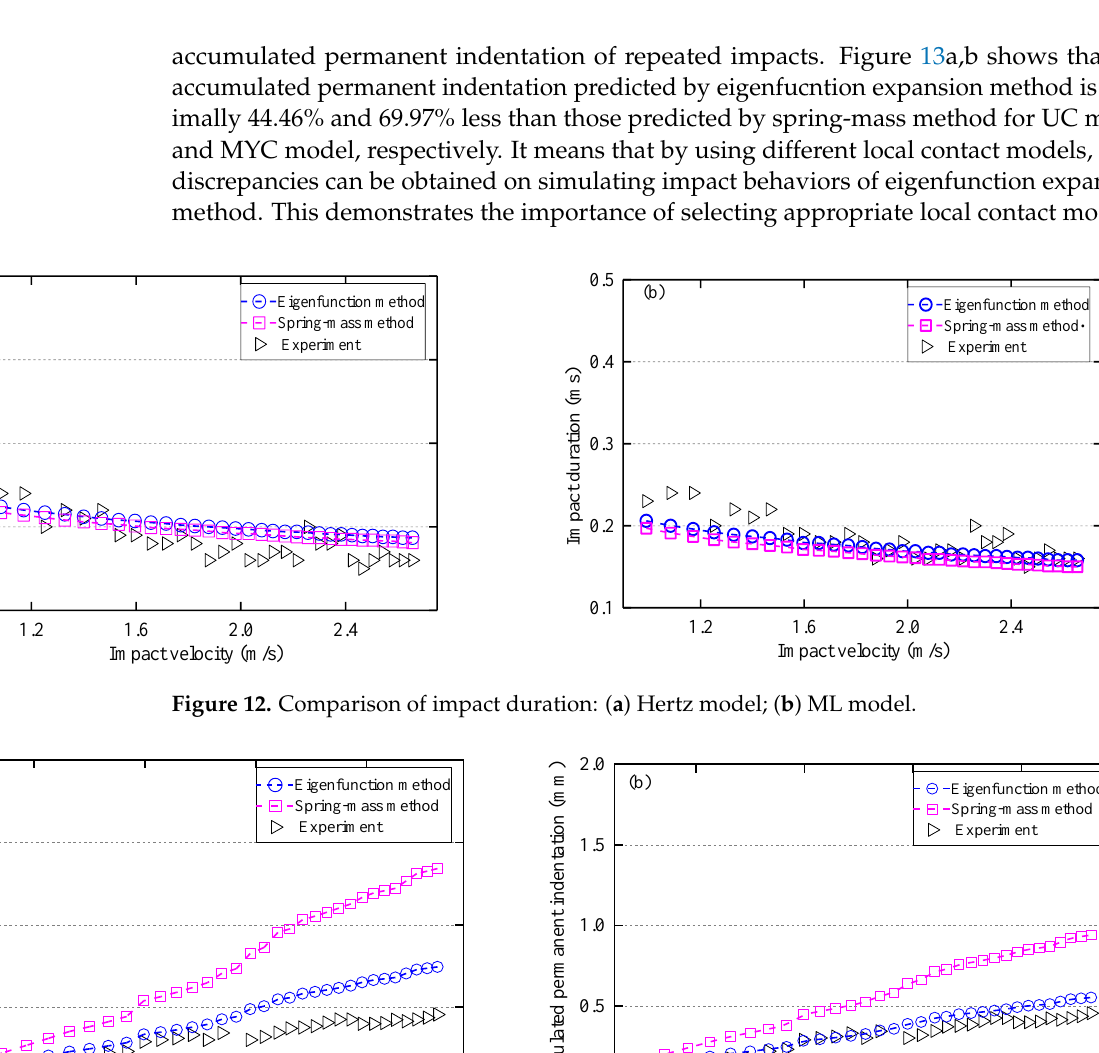
The coefficient of restitution (COR) is defined as the negative ratio of final relative velocity to initial relative velocity between the sphere and the beam at the impact loca- tion [30]. The calculations of the experimental COR require the velocity of the beam and the sphere at the end time of impact. In the experiments, the beam velocity is calculated from the measured displacement of the beam. The measured displacement is smoothed by using the Savitzky-Golay filtering algorithm, and the beam velocity is obtained by taking the derivative with respect to the smoothed beam displacement. The experimental separation velocity of the sphere V r is measured by solving the equations of the motion during separation stage, where the gravity is